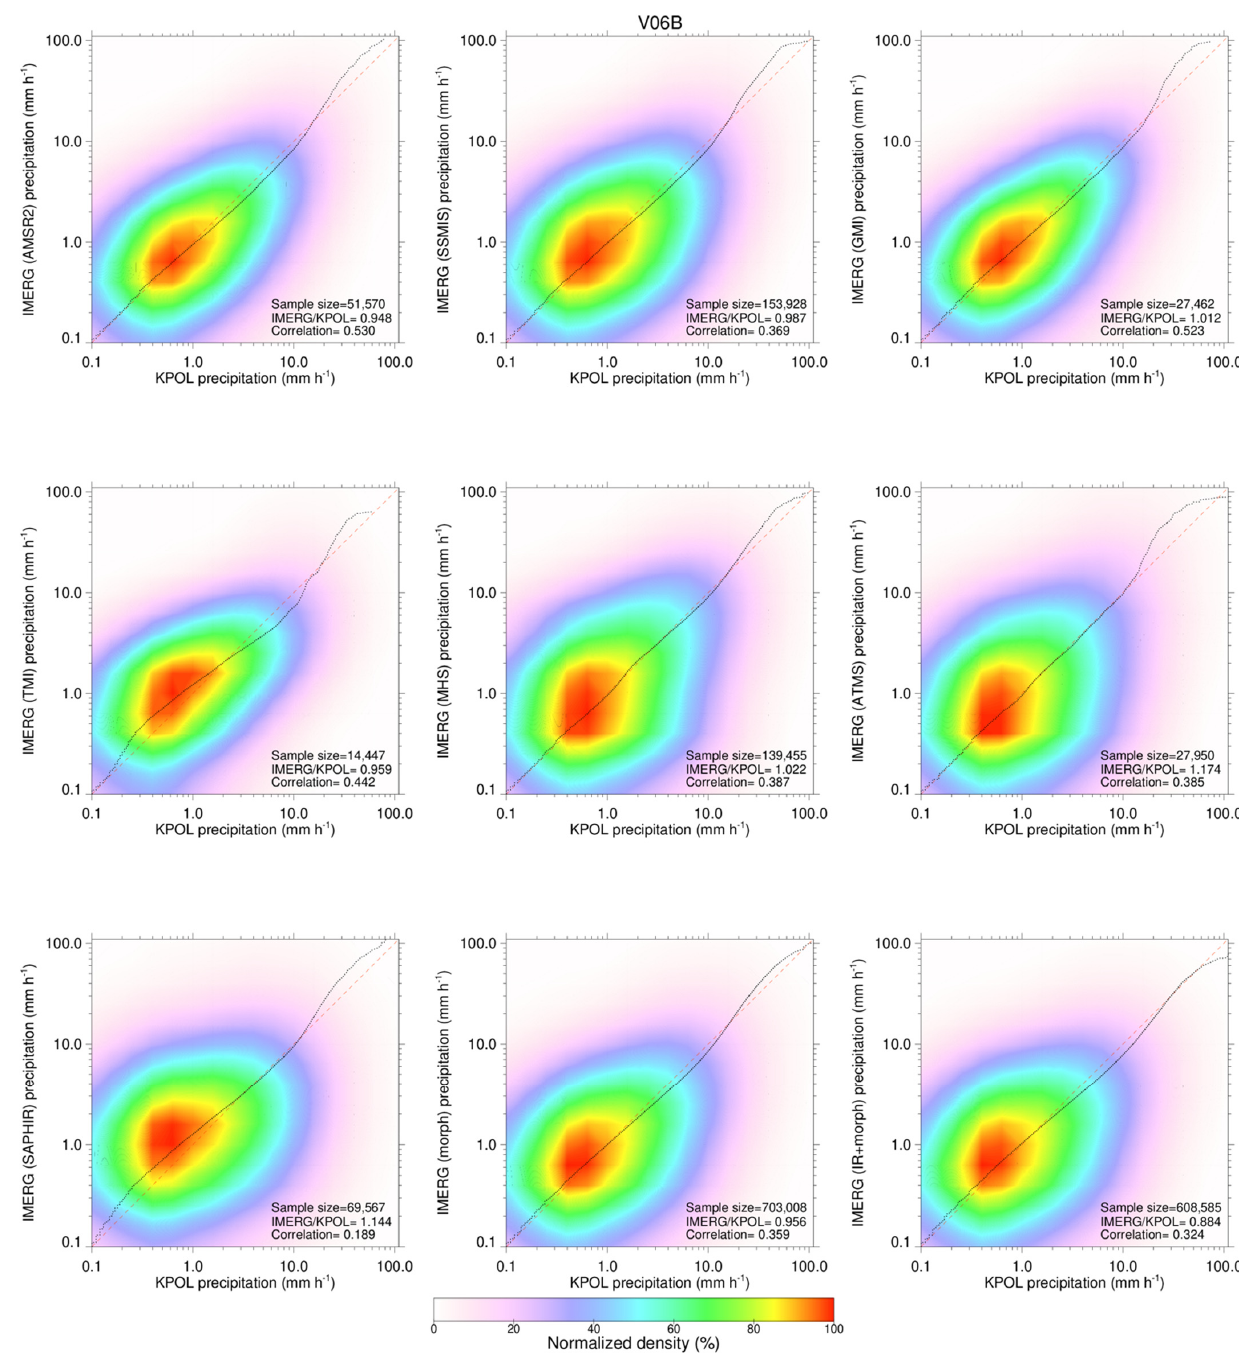
Figure 11. Same as Figure 10 but for IMERG V06B. For V06B (Figure 11), the random errors for imagers (AMSR2, GMI and TMI) are fairly low in comparison with all other categories as seen by the tighter scatters in the